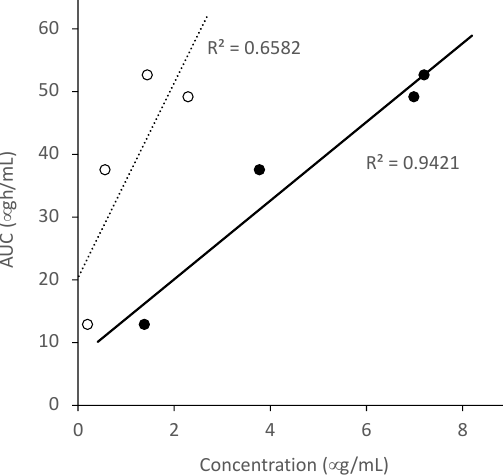
Figure 8. Relationship between final ALZ concentration in the µ Diss dissolution study at pH 6.8 (open) or LLPS concentration (closed) and AUC in rats.